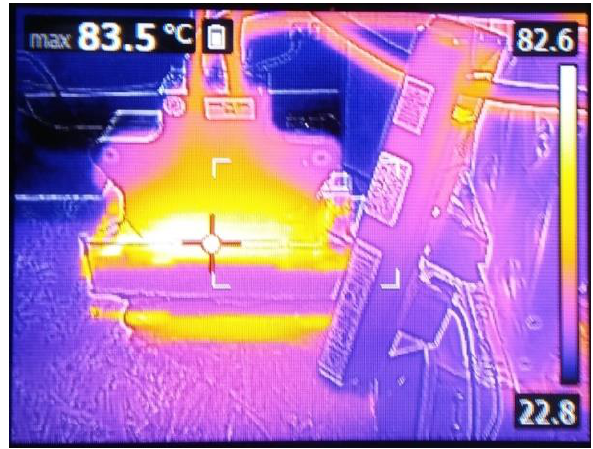
Figure 11. Temperature measurement of the second developed MFT with split windings at power of 45 kW without forced cooling.